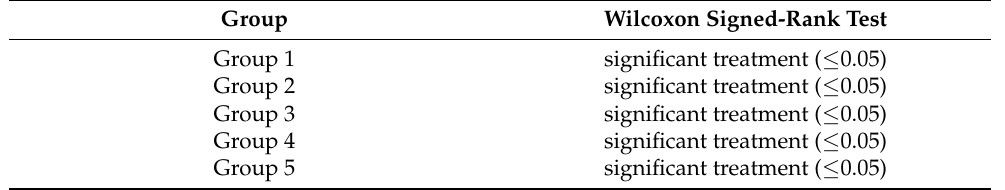
Table 4. Wilcoxon test results applied to each group.